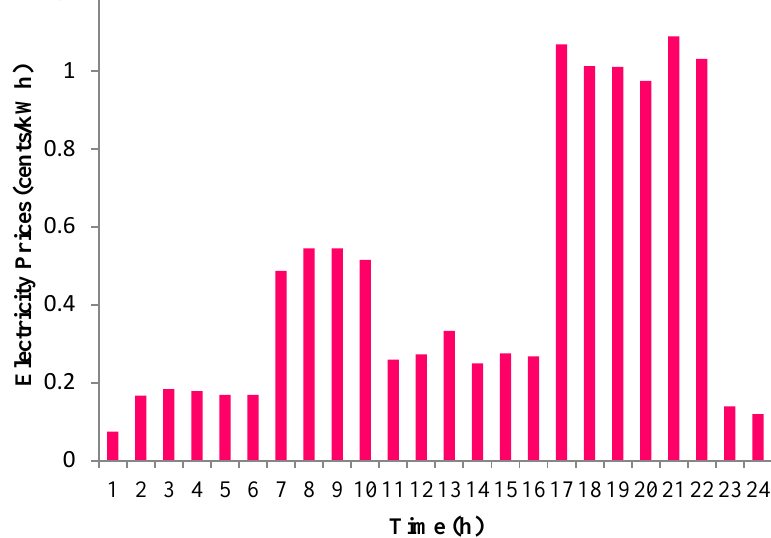
Figure 8. Predicted average electricity prices over a 24 h period.